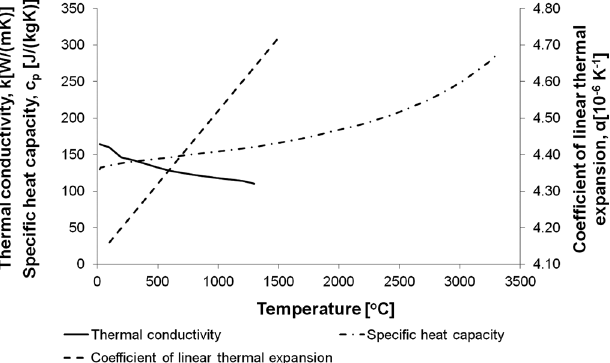
FIG. 11. Temperature-dependent thermal properties of W used for the material model of the collimator jaw inserts [29].